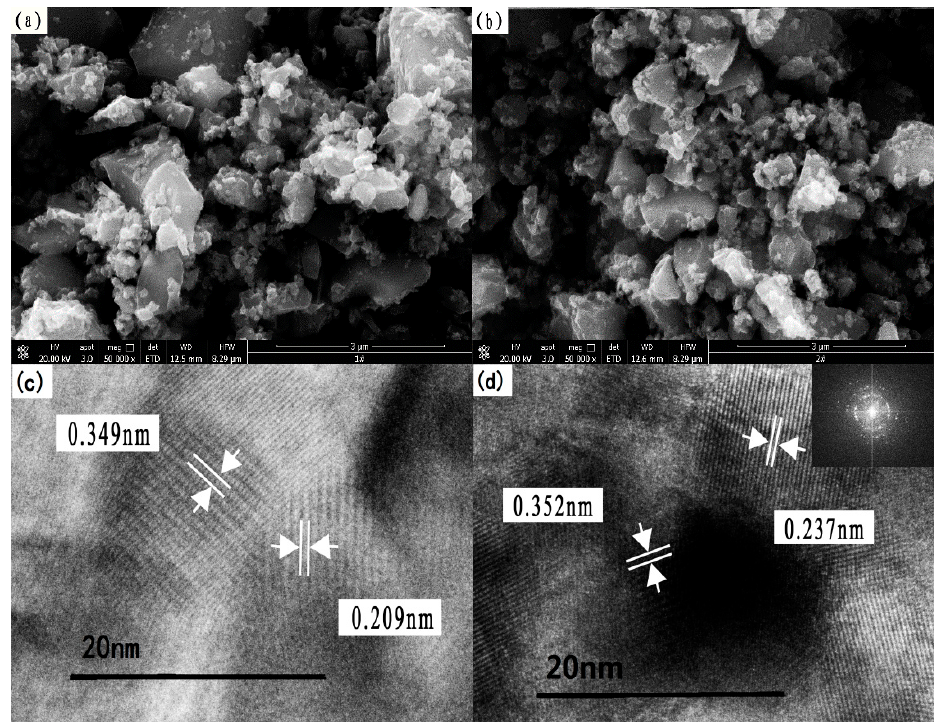
Figure 5. Scanning electron microscopy (SEM) and high-resolution transmission electron microscopy (HRTEM) images of samples: ( a ) SEM image of pure TiO 2 ; ( b ) SEM image of 0.75% La/TiO 2 ; ( c ) HRTEM micrograph of pure TiO 2 ; ( d ) HRTEM micrograph of 0.75% La/TiO 2 .